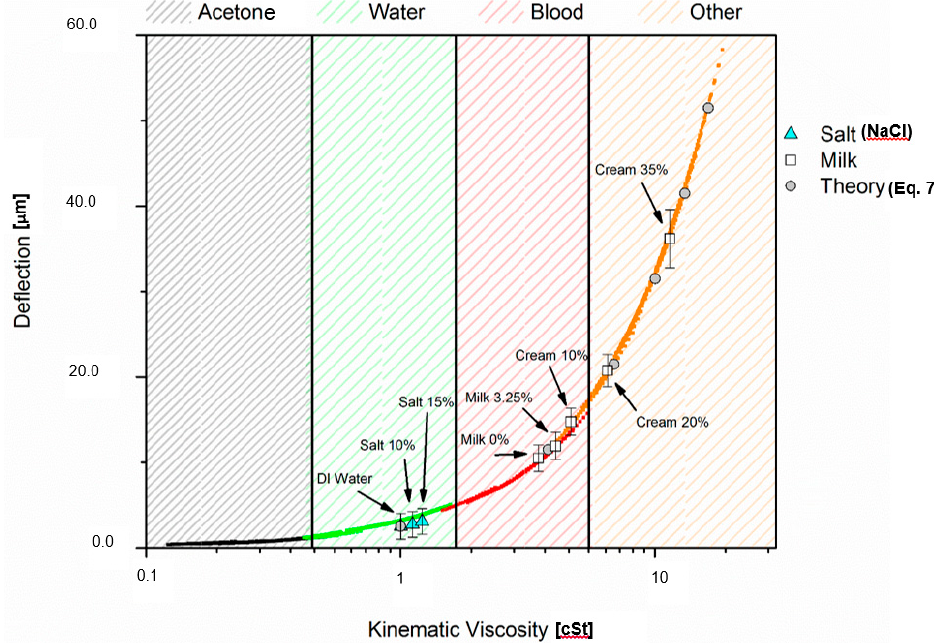
Figure 6. Prediction and experiment comparison of deflection behavior for various fluids; different ranges of fluids are indicated with colorful hatching and the cantilever deflection is shown with colorful dots.